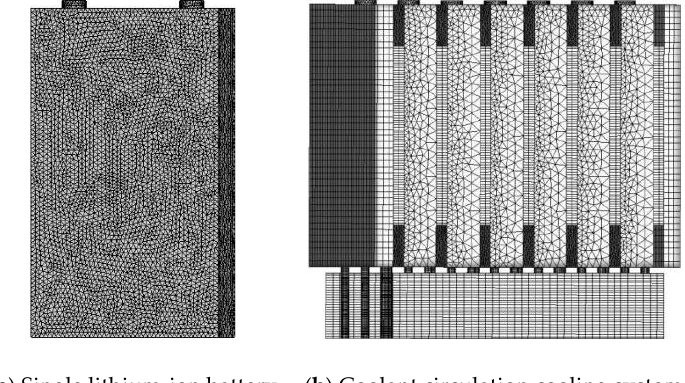
Figure 8. Simulation models meshing.